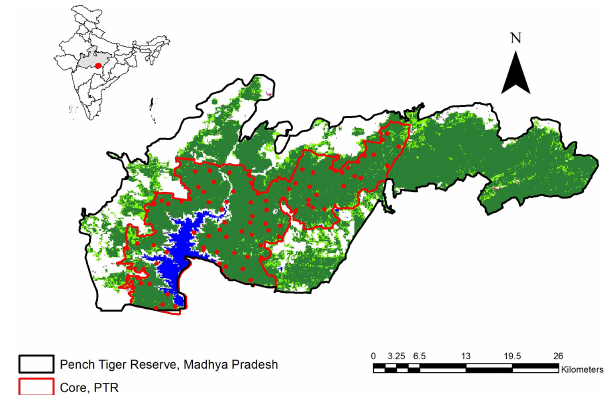
Figure 1. Location of camera trap stations in Pench Tiger Reserve, Madhya Pradesh (2013–2016). Map inset shows the location of Pench Tiger Reserve in